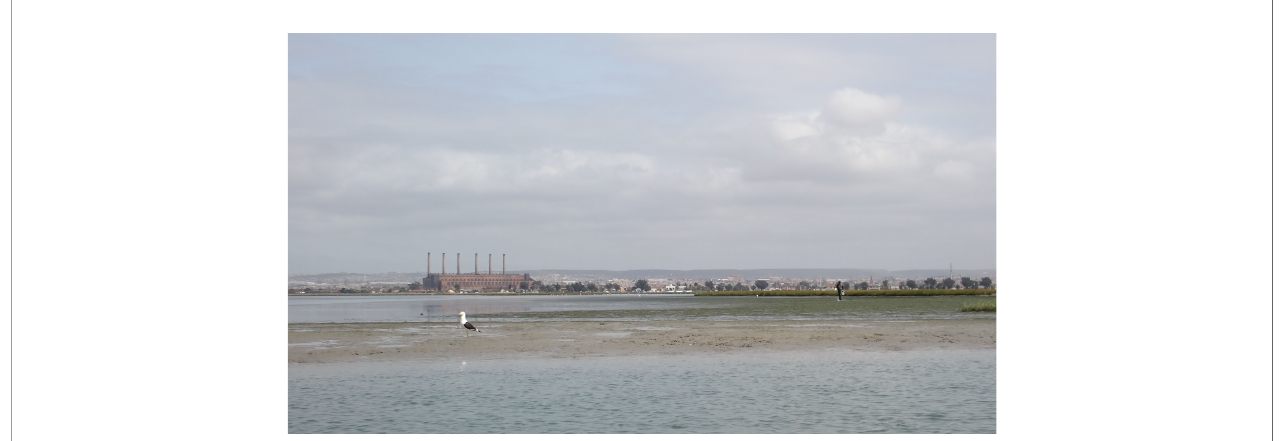
FIGURE 14 | The Swartkops estuary, where Jenny Rump works with the Zwartkops Conservancy to promote public awareness on caring for the river